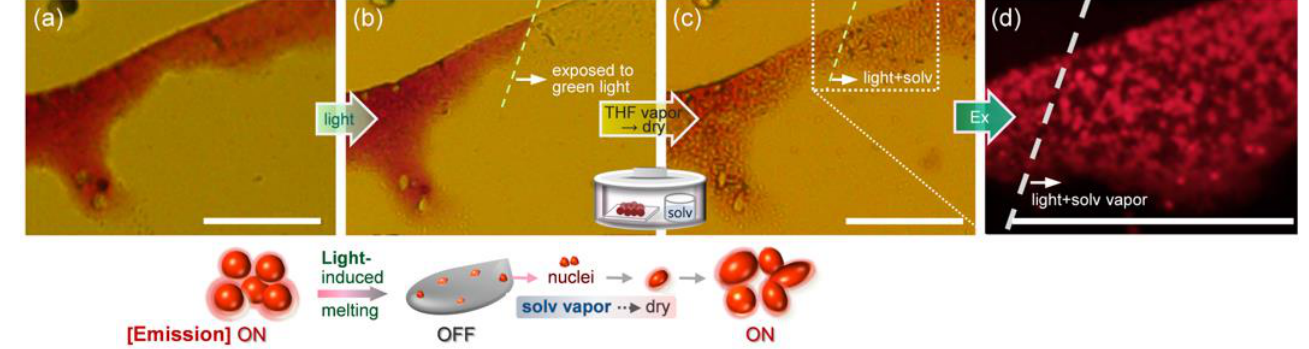
Figure 9. Reversible fluorescence switching: When spherical aggregates on a quartz substrate were exposed to ( a , b ) visible (green) light, a significant color change (due to light-induced melting) occurred with a reduction in the fluorescence intensity. ( c ) OM and corresponding ( d ) magnified FOM images taken after exposure of the sphere sample to THF vapor for 3 hours. Their morphological recovery caused the sample to fluoresce again. Scale bar: 50 m.